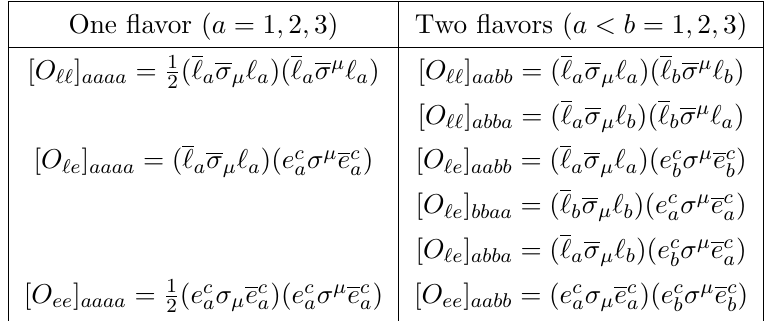
Table 1 . Flavor-conserving 4-lepton operators in the SMEFT